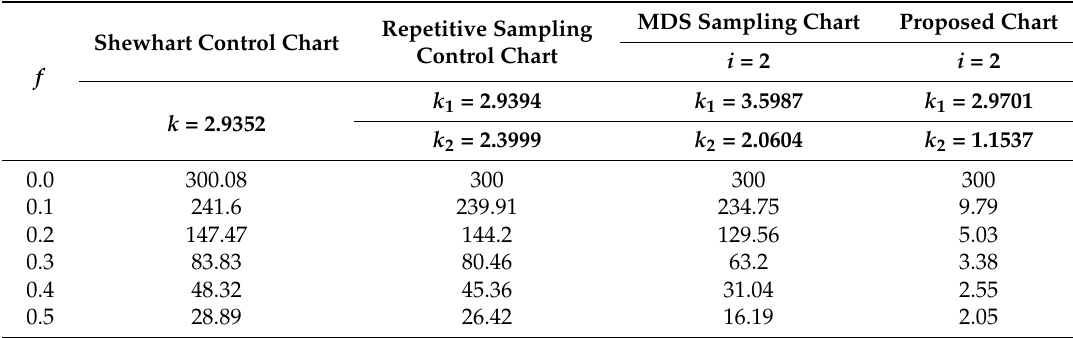
Table 7. ARL comparison when ARL = 300, n = 5, rho = 0.3.